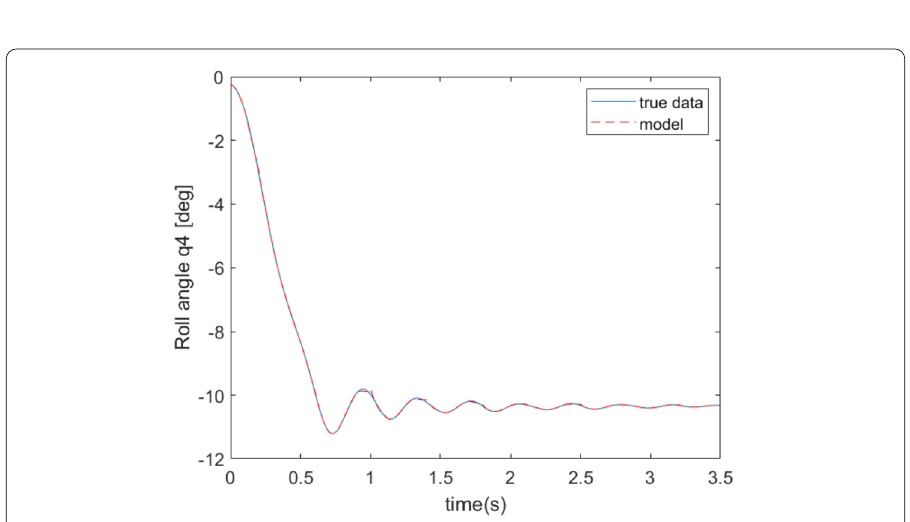
Figure 24 Model match between the identified nonlinear model with delay against the measured roll angle response